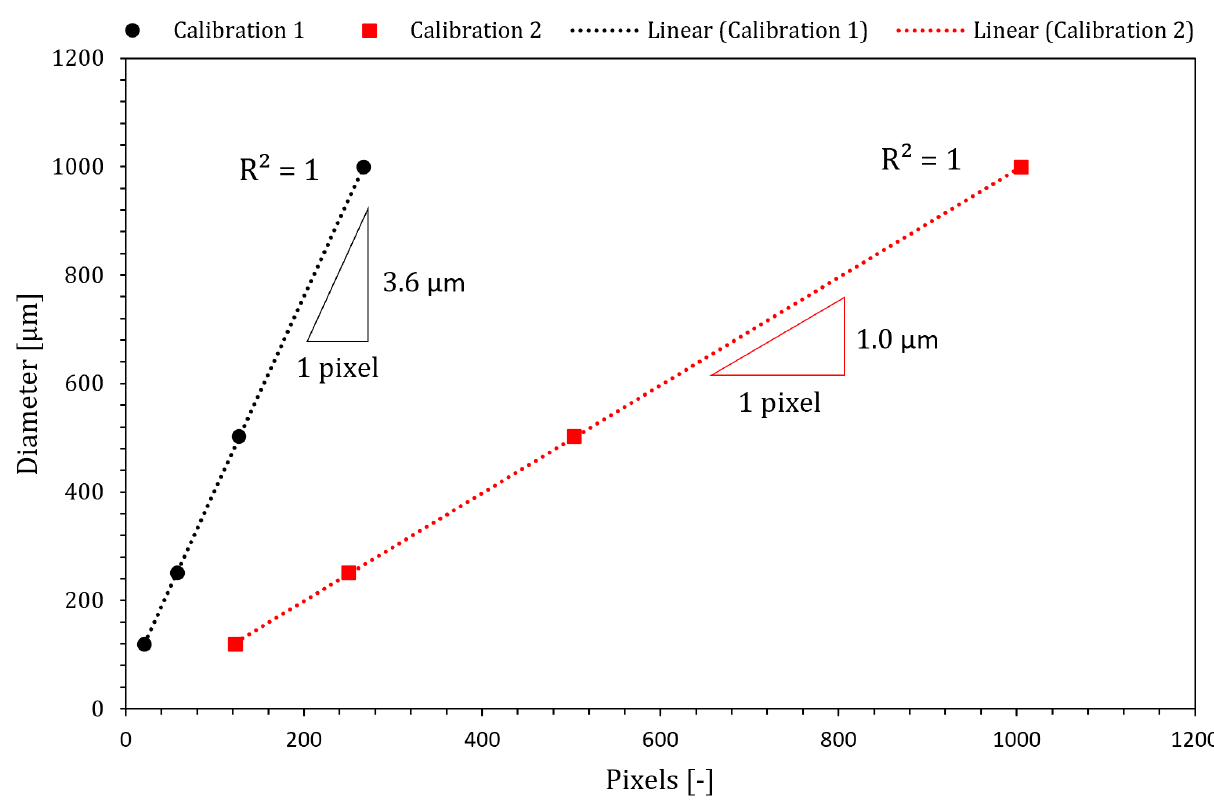
Figure 1. Calibration curves for the two optical configurations allowing recording at 20,000 fps with lower magnification (Calibration 1) and higher magnification (Calibration 2).